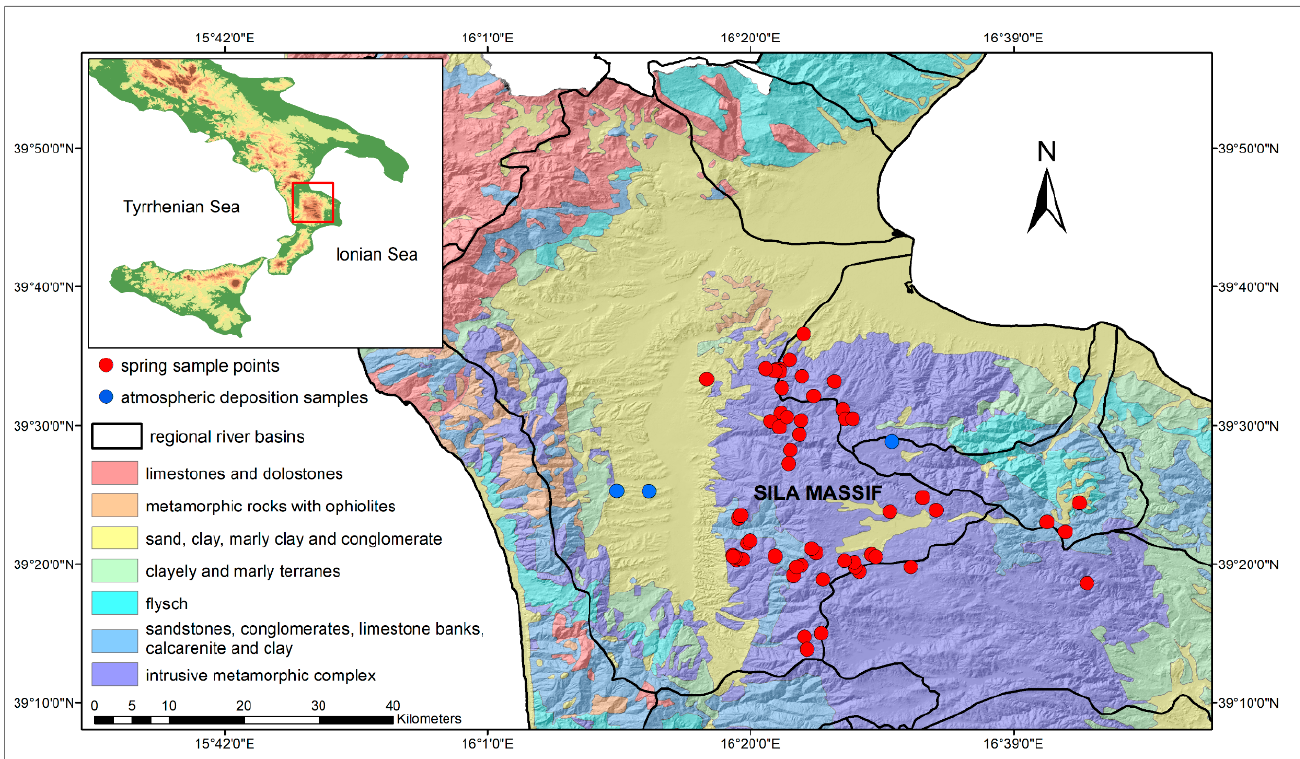
Figure 1. Map of the geographical and geological setting of the study area, with the locations of the samples.